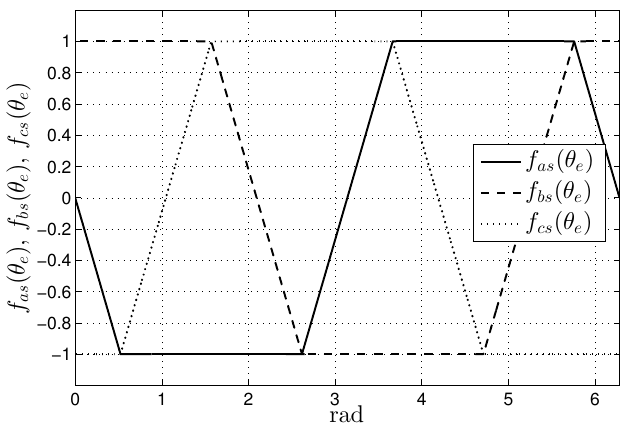
Figure 1. Back-EMF waveform fundamental functions f as ( θ e ) , f bs ( θ e ) and f cs ( θ e )